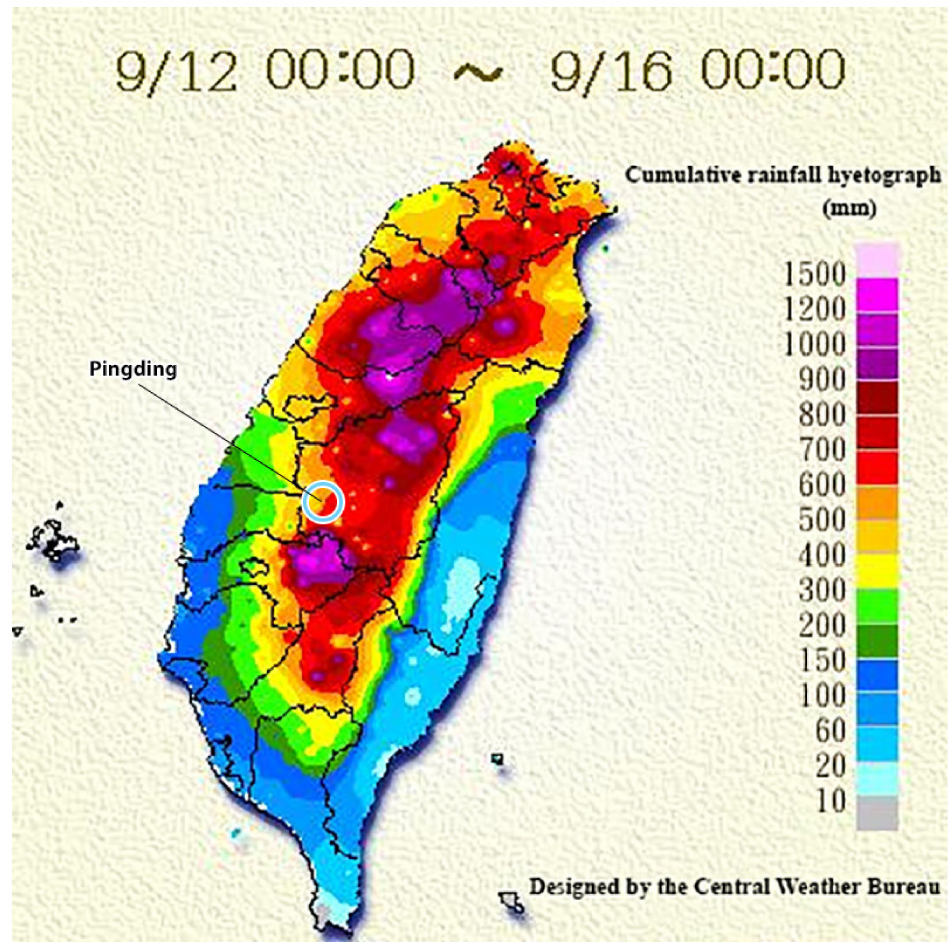
Figure 11. The cumulative rainfall from 12 to 16 September during Typhoon Sinlaku in